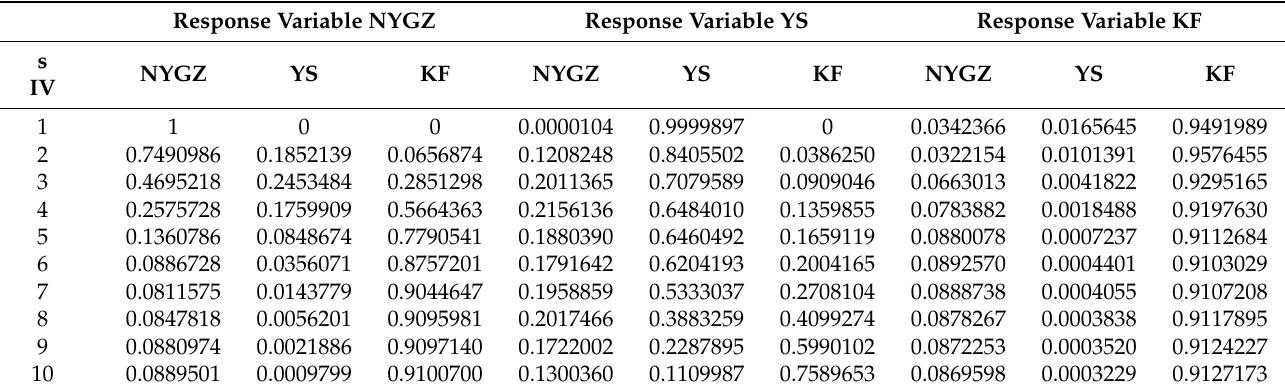
Table 9. Variance decomposition results of NYGZ, YS and